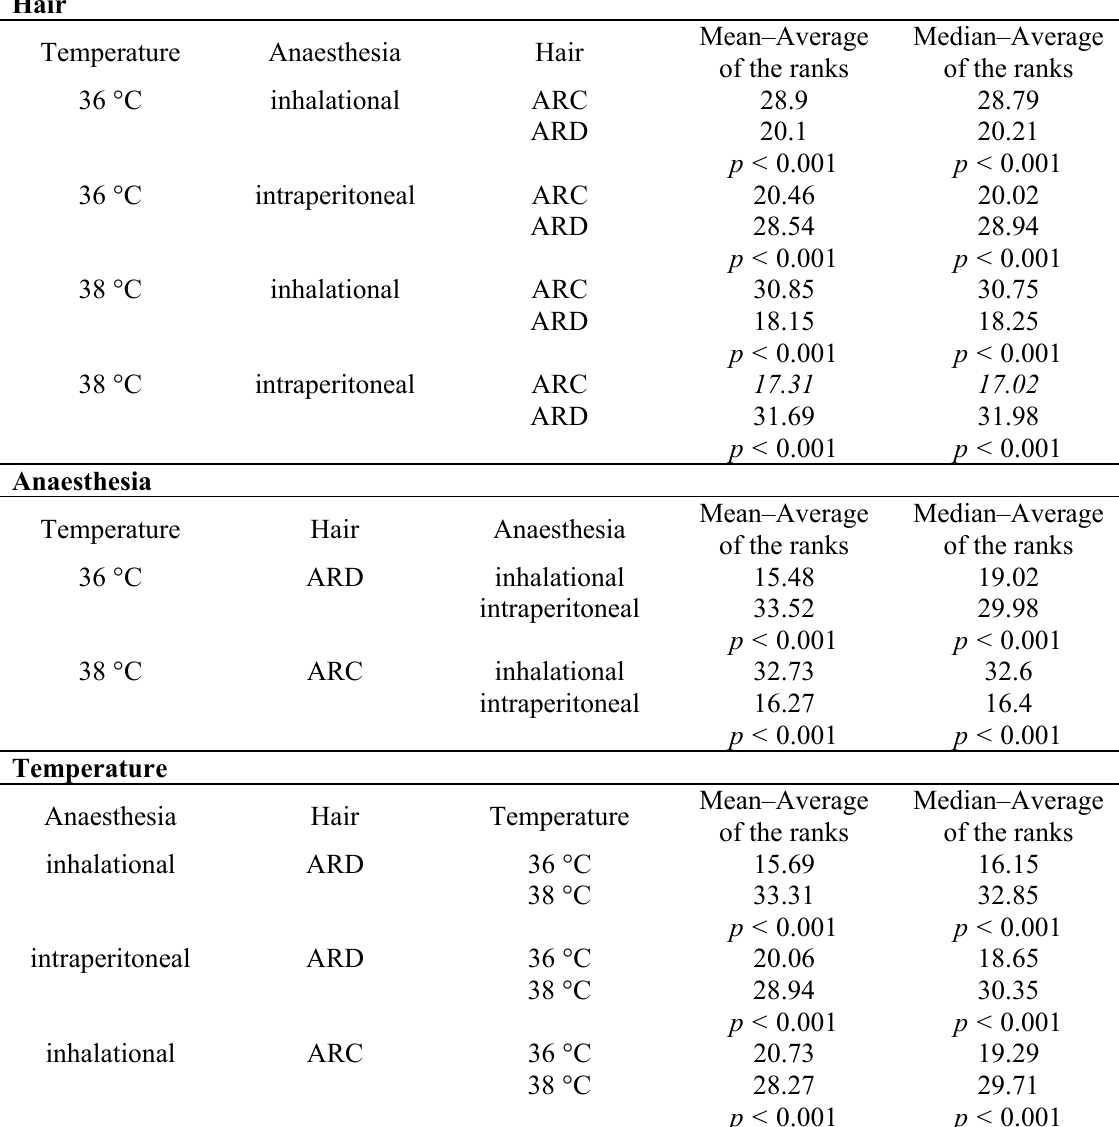
Table 4. Inferential Statistics. The results of a Mann-Whitney test for the effects of hair, anaesthesia and temperature when the mouse is placed in the ventral decubitus